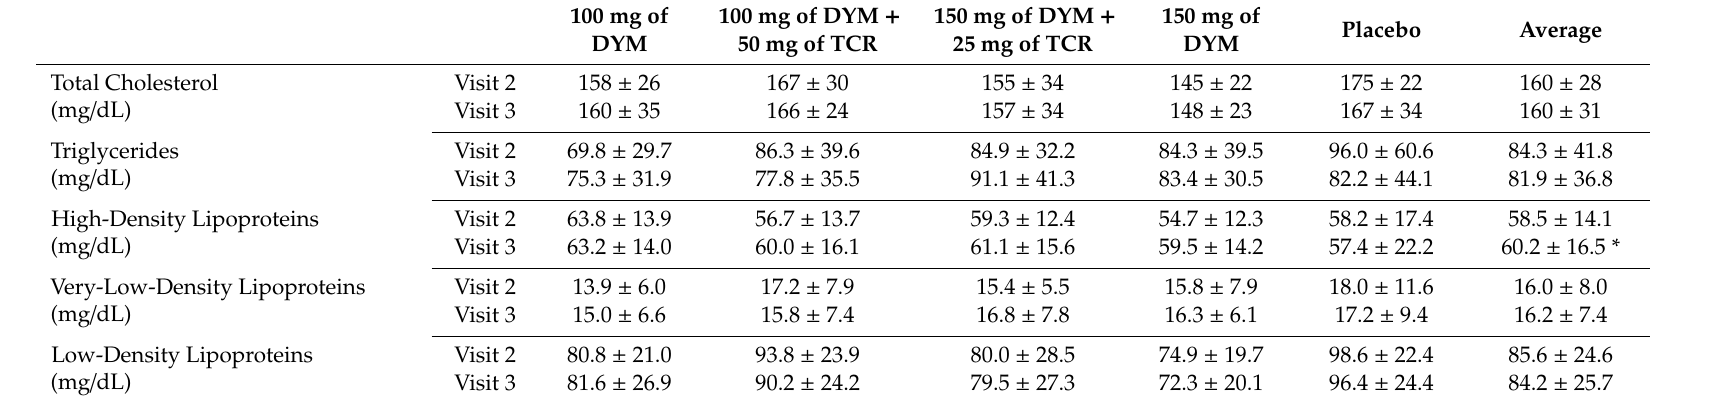
Table 7. Group ( n = 25 per group) and average lipid panel comparisons between Visits 2 and